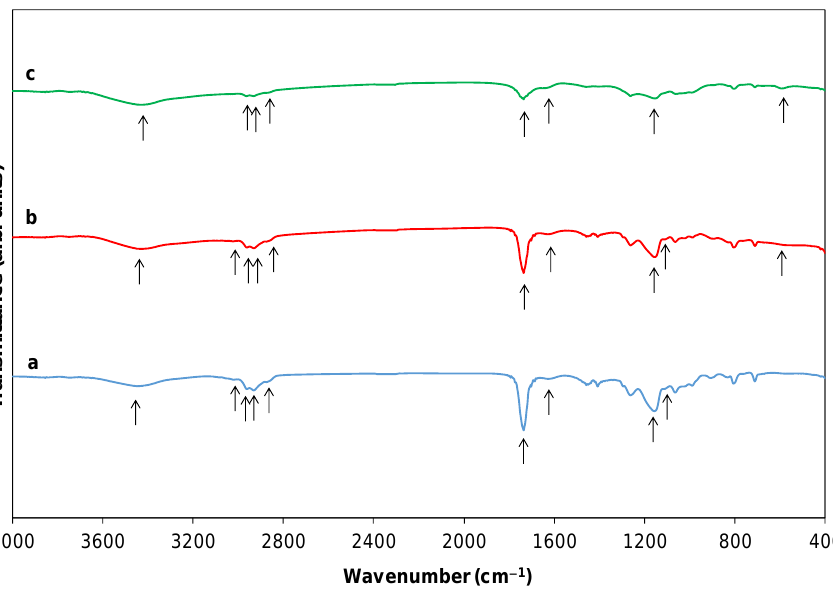
Figure 1. Normalized IR spectra of the template (a), of the template + TiCl 4 and TbCl 3 mixture + HCl aq after 2 h of reaction (b) and after 5 h of reaction (c), i.e., of the Ti 1−x Tb x [(OH) 4−u Cl v ]@PST – PDVB intermediate compound (Tb content in (b) and (c) is 0.12 at.%). Arrows are added in order to follow the evolution of the IR bands being the related reactions explained in the text.